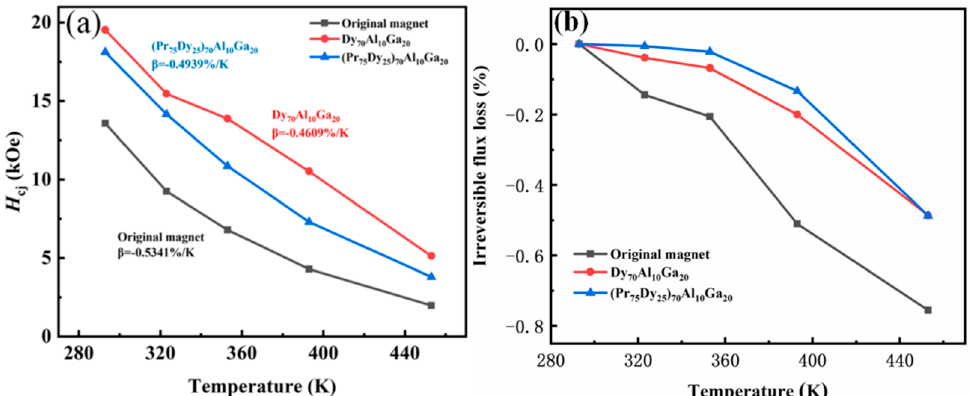
Figure 3. ( a ) the coercivity curves of the original magnets and the Dy 70 Al 10 Ga 20 and (Pr 75 Dy 25 ) 70 Al 10 Ga 20 diffusion magnets in the temperature range of 293–453 K; ( b ) the irreversible flux loss curve of the original magnets and the diffused Dy 70 Al 10 Ga 20 and (Pr 75 Dy 25 ) 70 Al 10 Ga 20 magnets at 293–453 K.